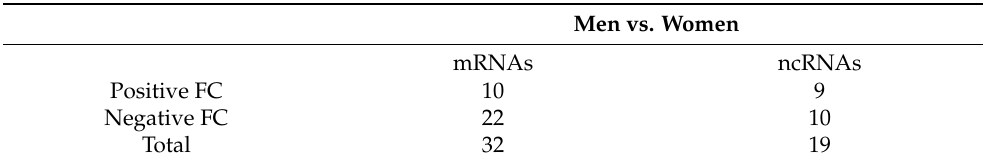
Table 1. Number of differentially expressed coding and non-coding RNAs after transcriptome analysis, divided according to their Fold Change (FC).